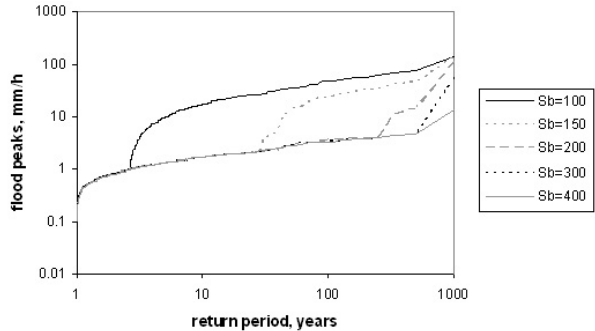
Fig. 8. Flood frequency curves generated by Model 4 using η =0.5 and various S b